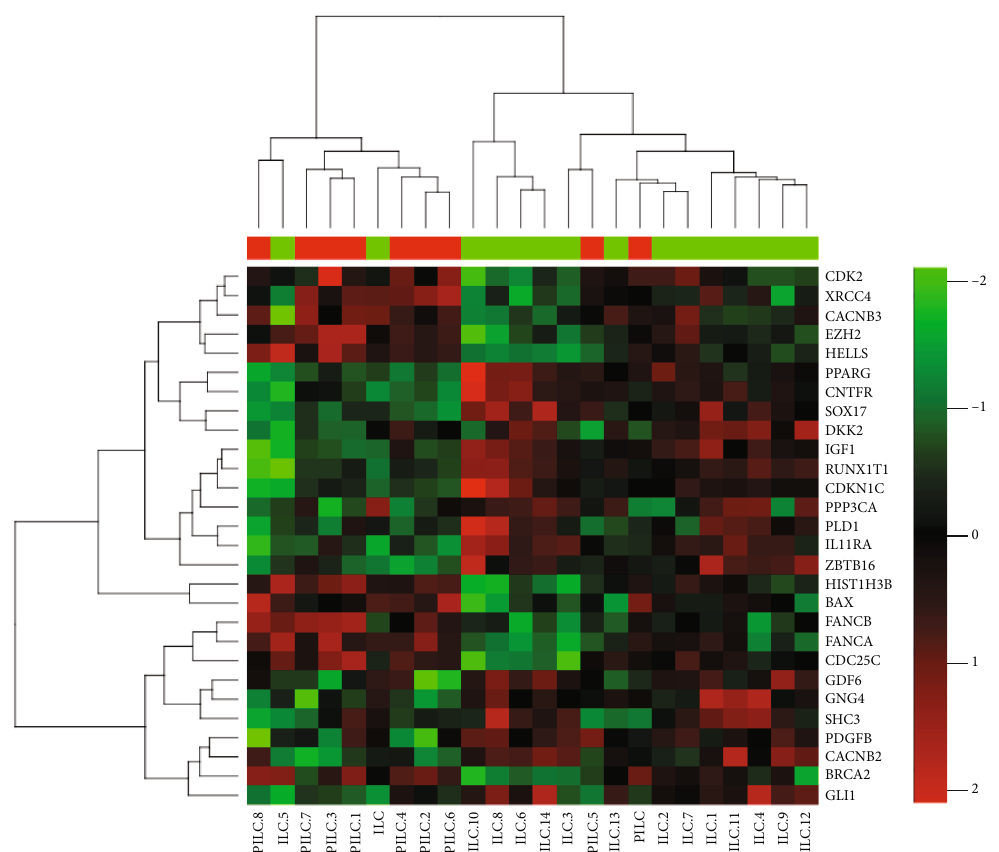
Figure 4: Heat map showing cluster of genes associated with PILC subtype that are di ff erentially expressed than ILC